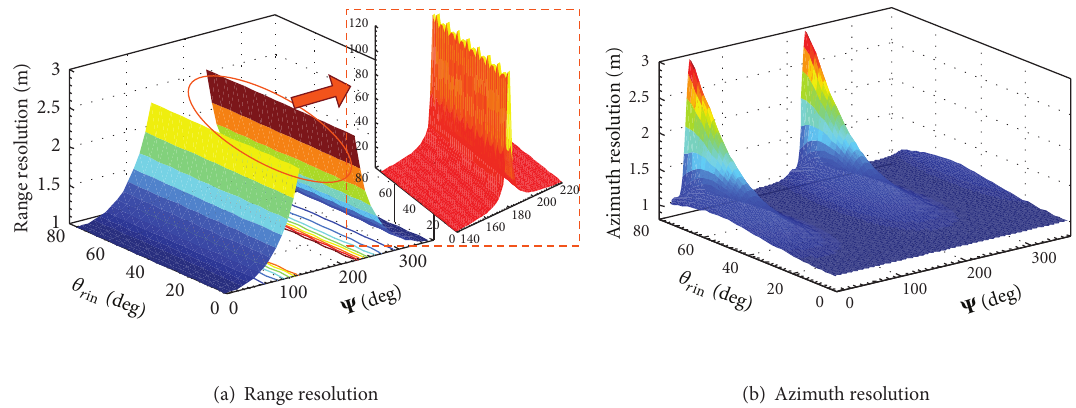
Figure 6: Range resolution (a) and azimuth resolution (b) as two functions of 𝜃 𝑟